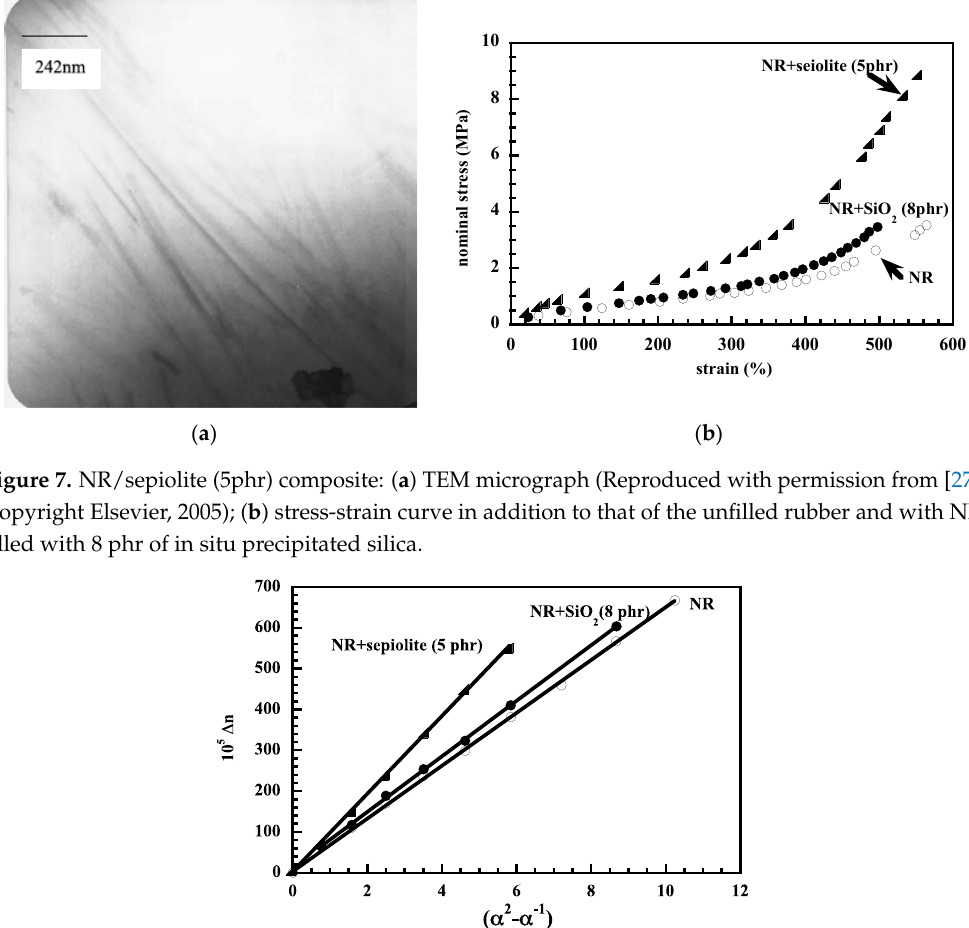
Figure 8. Birefringence measurements for unfilled NR and for composites. Reproduced with permission from [27]. Copyright Elsevier, 2005. from [27]. Copyright Elsevier,